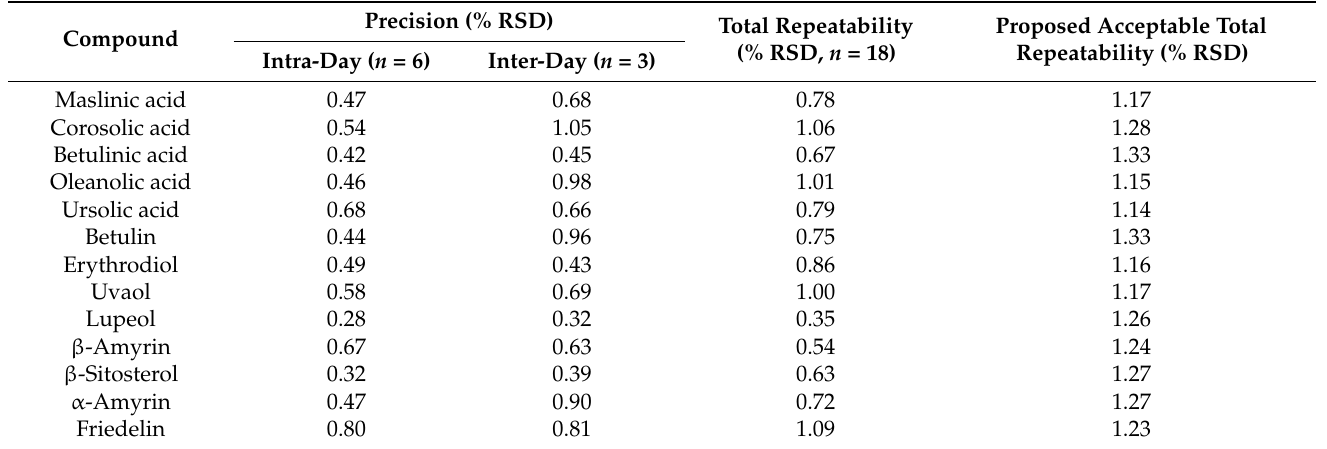
Table 2. Precision data of triterpenoids.